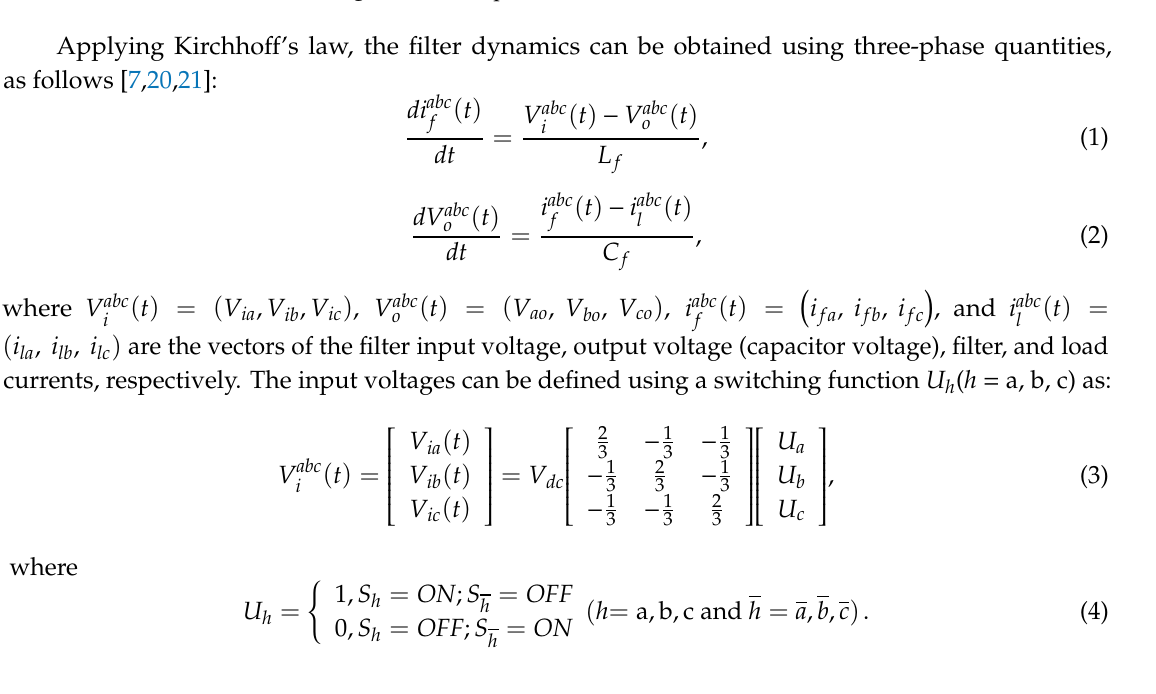
Figure 1. Three-phase inverter with LC filter.